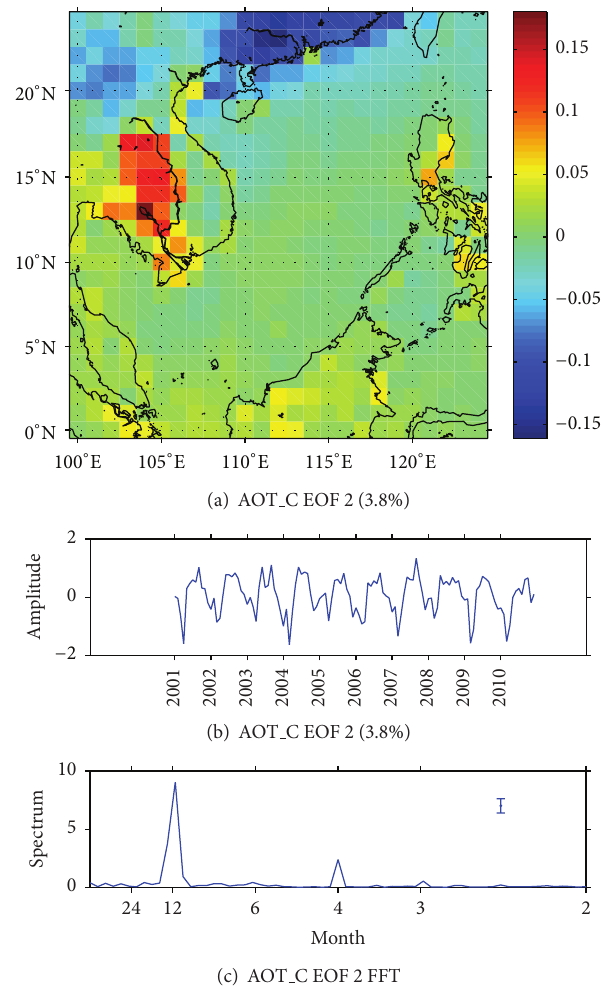
Figure 3: The same as Figure 2 but EOF mode 2 of AOT